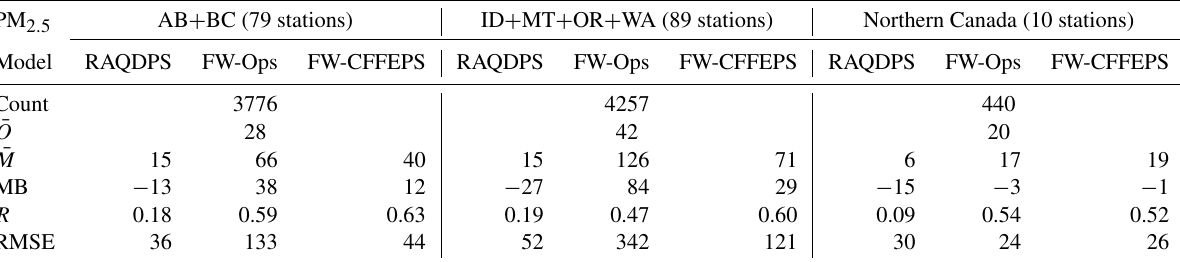
Table 8. Model performance statistics for daily maximum surface PM 2 . 5 concentration (µgm − 3 ) for 1 August to 18 September 2017 for stations in AB + BC, ID + MT + OR + WA, and northern Canada regions. PM 2 .